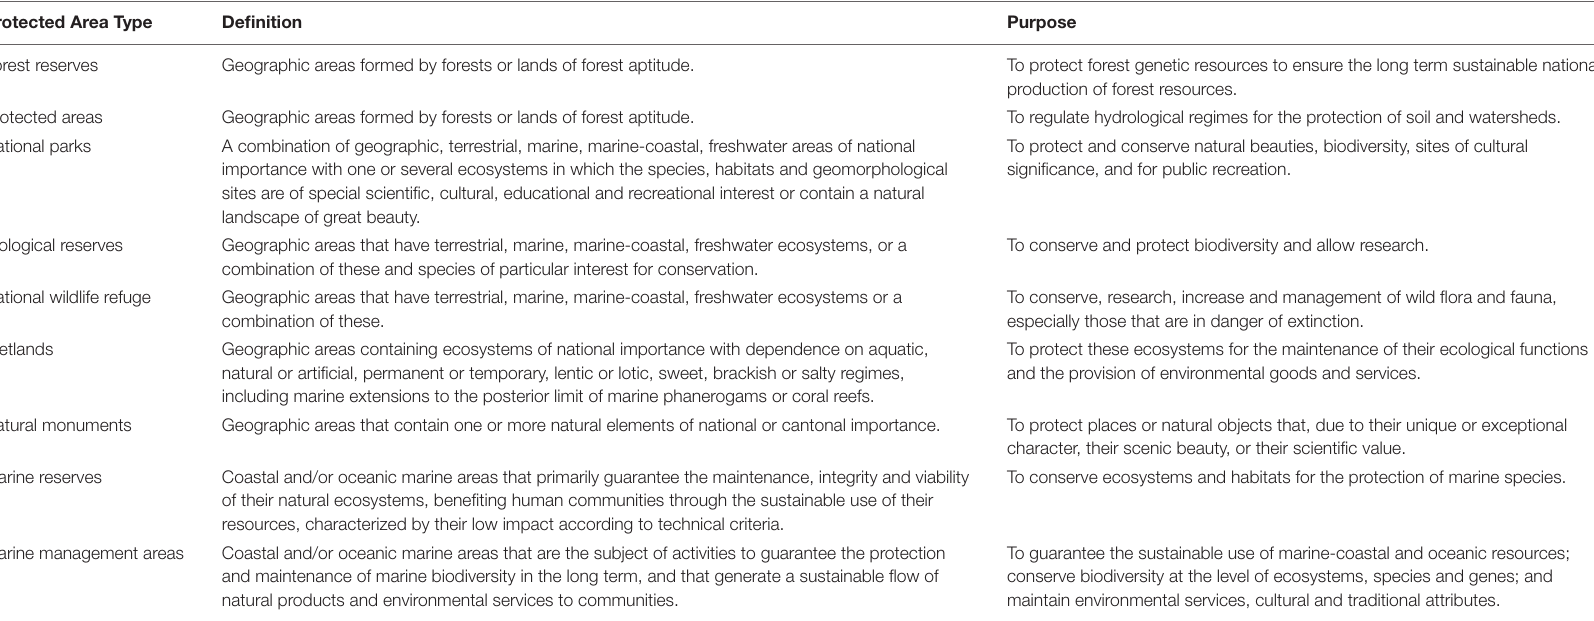
TABLE 1 | Costa Rica’s nine protected area types, their descriptions, and purposes according to the System of National Conservation Areas [adapted from Sinac and Minae, 2017]. Protected Area Type